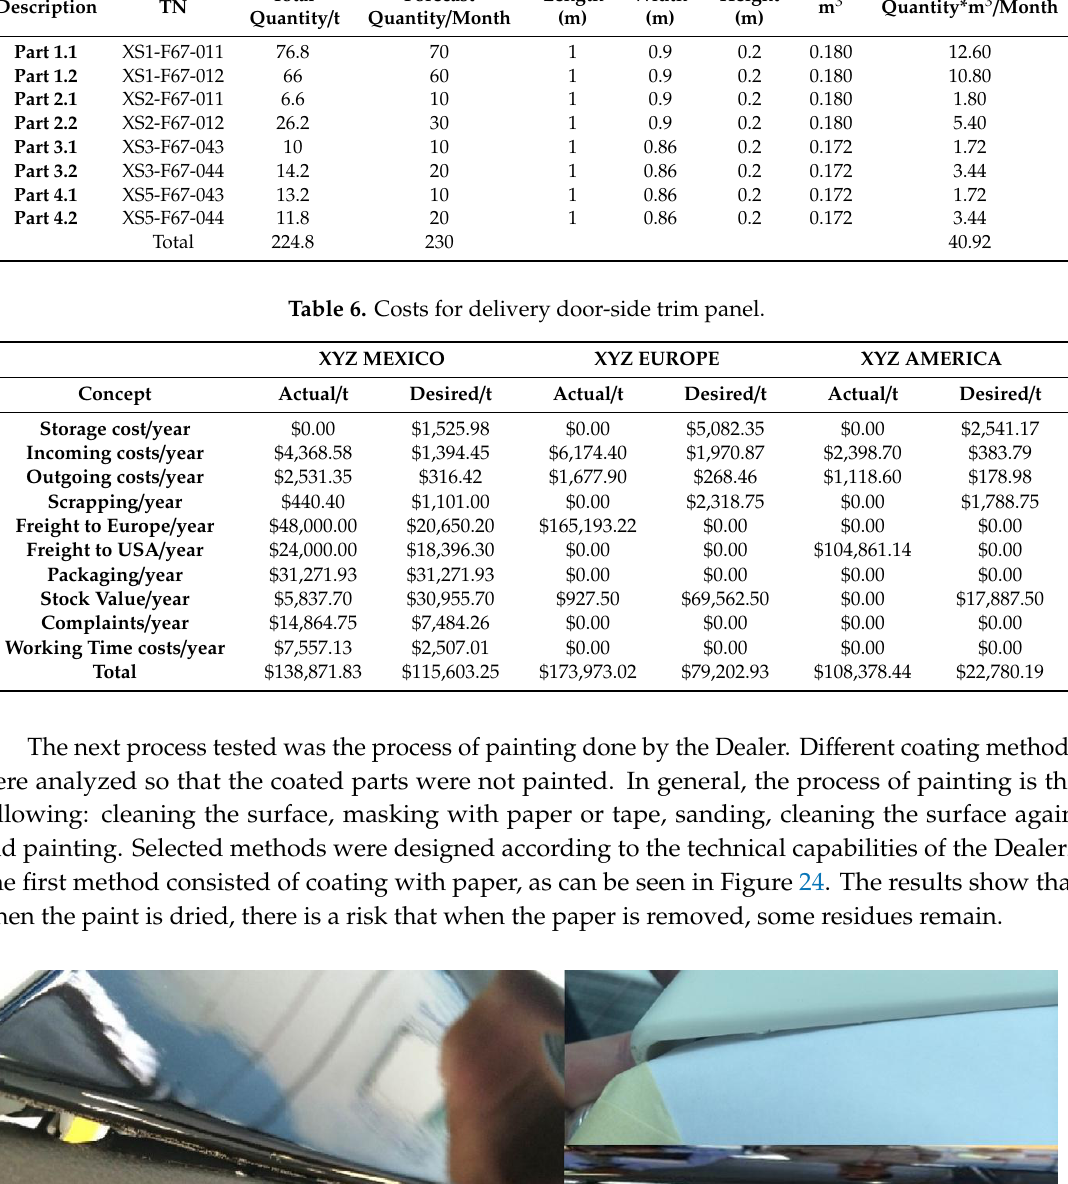
Figure 25. Painting process using masking tape. The third method consisted of using tape 3M with stiffened edges and masking tape. The results are shown in Figure 26. As can be seen, the results are satisfactory and comply with the internal standard of the company XYZ for interior painting. The tests carried out for this method were: verification of gaps, laboratory tests for layers of paint of the top shoulders (layer thickness, adhesion, condensed moisture and hydrolysis test) and transparency test on painted top shoulders during the operation of environmental lights. The painting process for this method took 130 min per part. Figure 26. Painting with tape 3M with stiffened edges and masking tape.